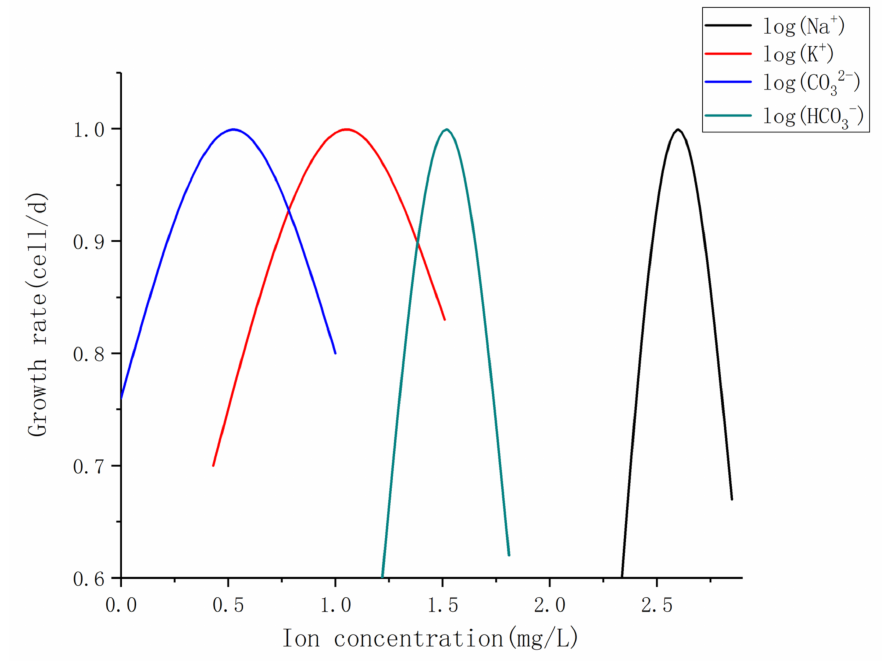
Figure 1. The influence curves of ion conditions on growth rate (Na + , K + , CO 32 − , and HCO 3 − ). When the concentration was low, each factor had a positive effect on the growth rate, which was under the effect of the main model. The contribution of the quadratic term became more and more important with the increase in the independent variable. When the independent variable exceeded a certain value, the single factor changed the growth rate to a negative effect. The growth rate of P. parvum first increased and then decreased with increasing ion concentrations. The growth rate reached the theoretically highest point of 0.999 with Na + , K + , CO 32 − , and HCO 3 − concentrations of 397.98, 11.60, 3.37, and 33.31 mg/L,